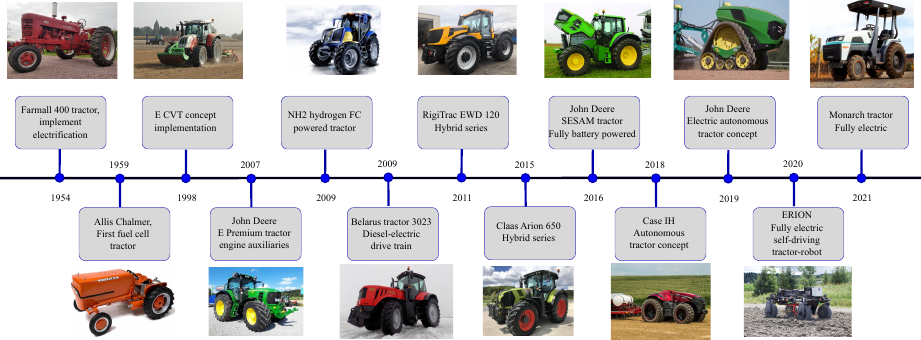
Figure 2. Historical timeline of some commercial hybrid electric tractors in agriculture